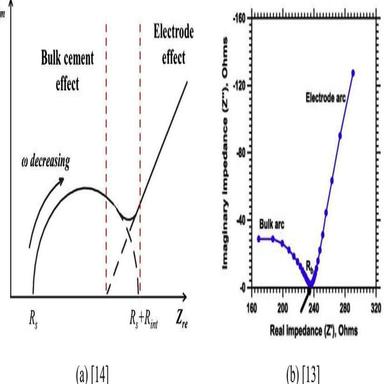
The theoretical (a) and measured (b) Nyquist plot from AC impedance spectroscopy.